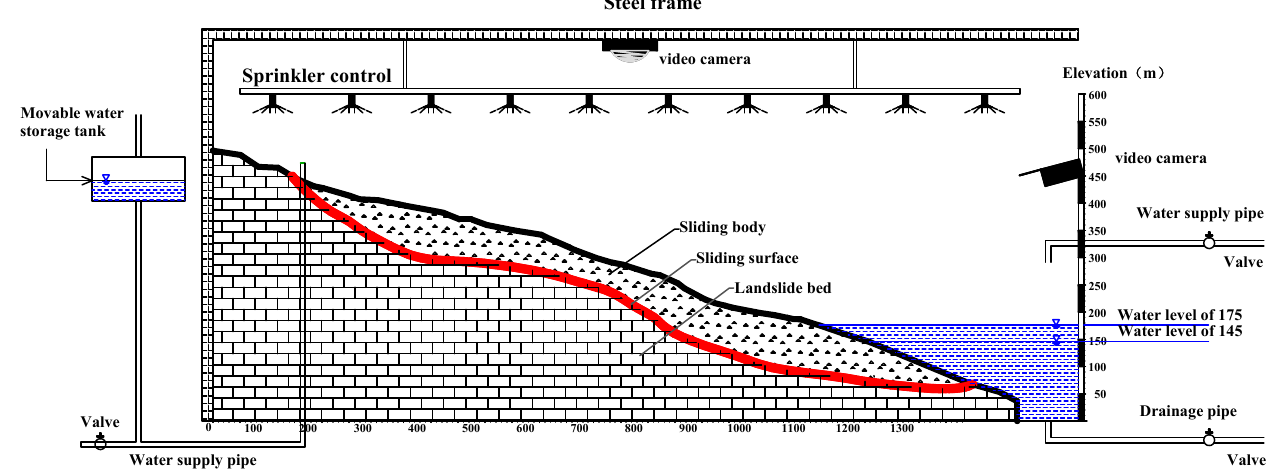
Figure 4. Landslide model test system.